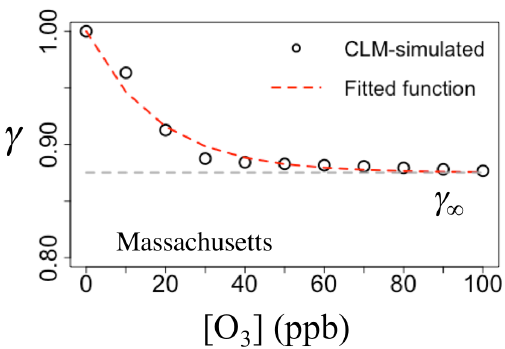
Figure 1. Relationship between the ozone impact factor, γ , for rel- ative LAI changes in Eq. (6) and surface ozone concentration in summer (JJA), using the grid cell covering Massachusetts as an ex- ample. Black circles refer to γ raw directly calculated from CLM- simulated results, and the red dashed line refers to γ opt in Eq. (7) that is obtained by